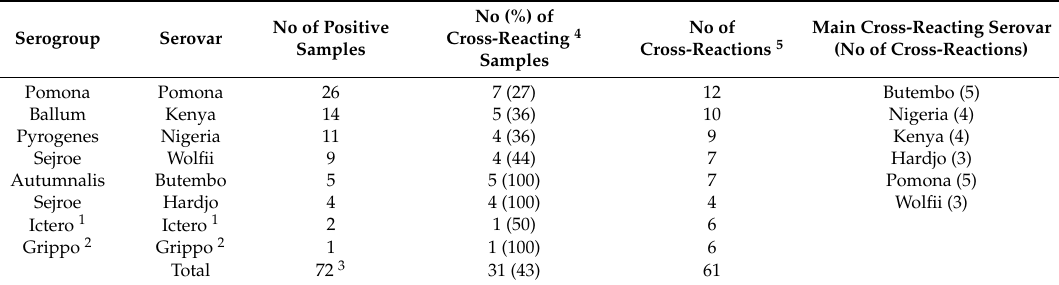
Figure 1. Frequency histogram showing the number of seropositive sera of cattle ( n = 275) from Mbale and Kole districts in Uganda at each MAT titer to different Leptospira serovars or serogroups (one animal may be seropositive against several serovars). Table 4. Number and percentage of positive serum samples cross-reacting with other serovars and number of cross-reactions per serovar and serogroup.